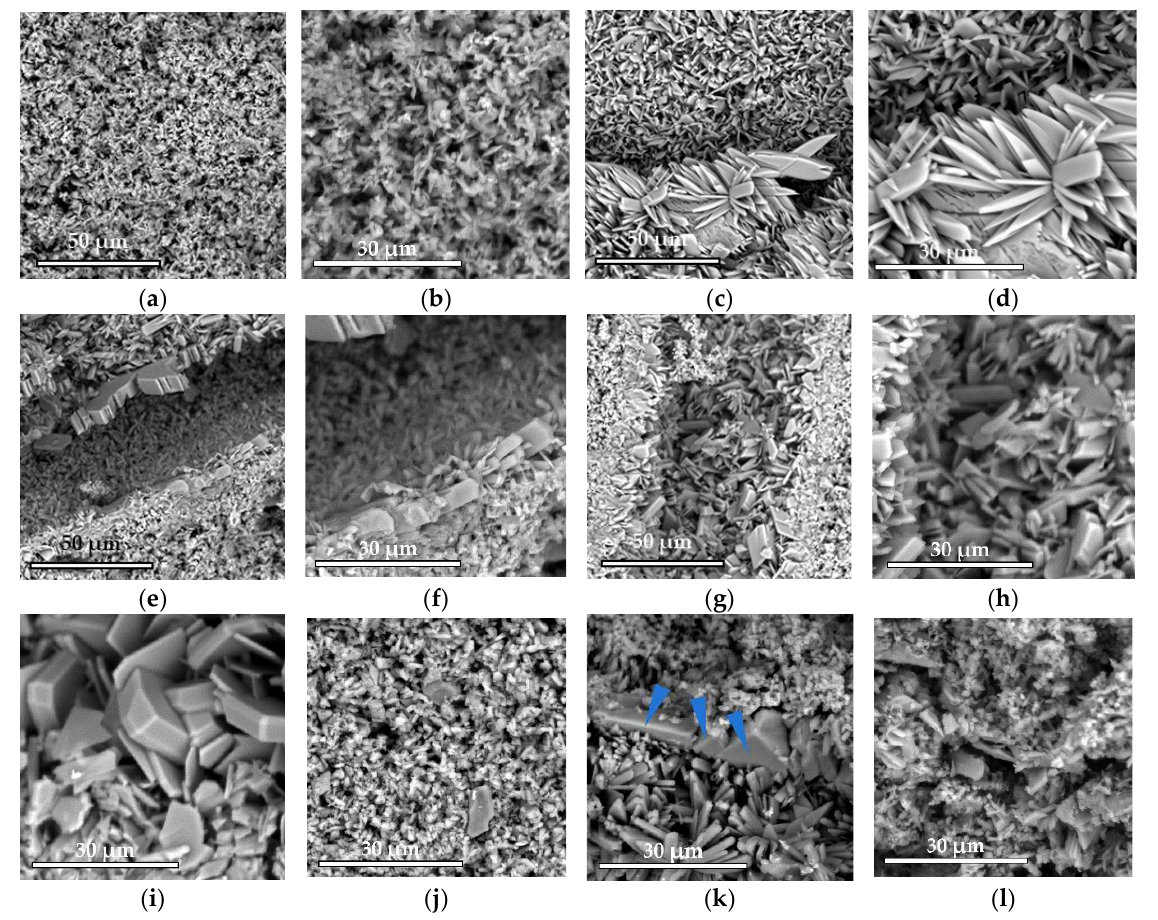
Figure 5. Micrographs of ceramics: N0_LP0.6 ( a – d ); N0_SPP_LP0.6 ( e , f ); N0_CA_LP0.6 ( g , h ); N0_LP0.7 ( i ); N20_LP0.7 ( j ); N40_LP0.7 ( k ); N60_LP0.7 ( l ). Magnification ×2500 for ( a ), ( c ), ( e ), ( g ). Magnification ×5000 for ( b ), ( d ), ( f ), ( h – l ).